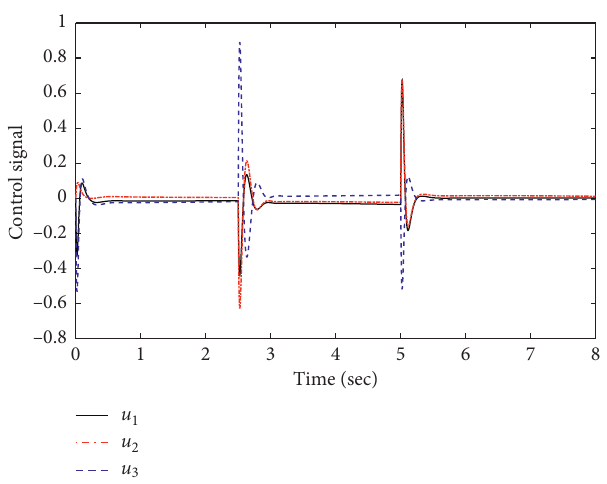
Figure 14: Control signal of the system under load variations and mismatched